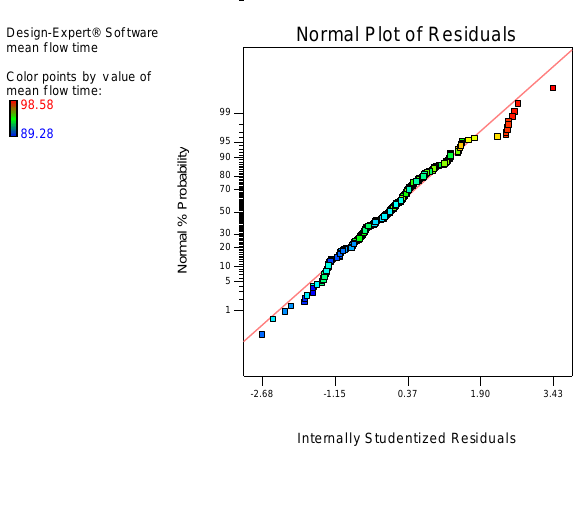
Figure 3. Normal plot of residuals